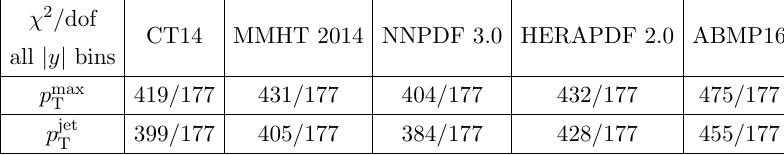
Table 3 . Summary of (cid:31) 2 = dof values obtained from a global (cid:12)t using all p T and rapidity bins, com- paring the inclusive jet cross-section and the NLO pQCD prediction corrected for non-perturbative and electroweak e(cid:11)ects for several PDF sets and for the two scale choices. All the corresponding p -values are (cid:28) 10 (cid:0) 3 .